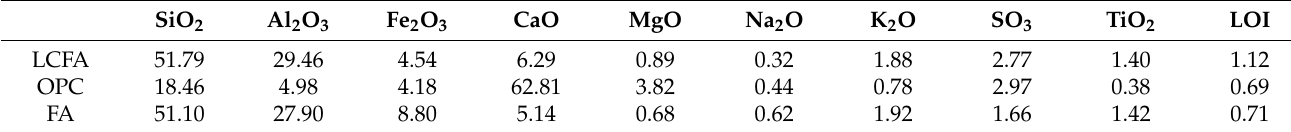
Table 1. Main chemical composition of raw materials wt%.